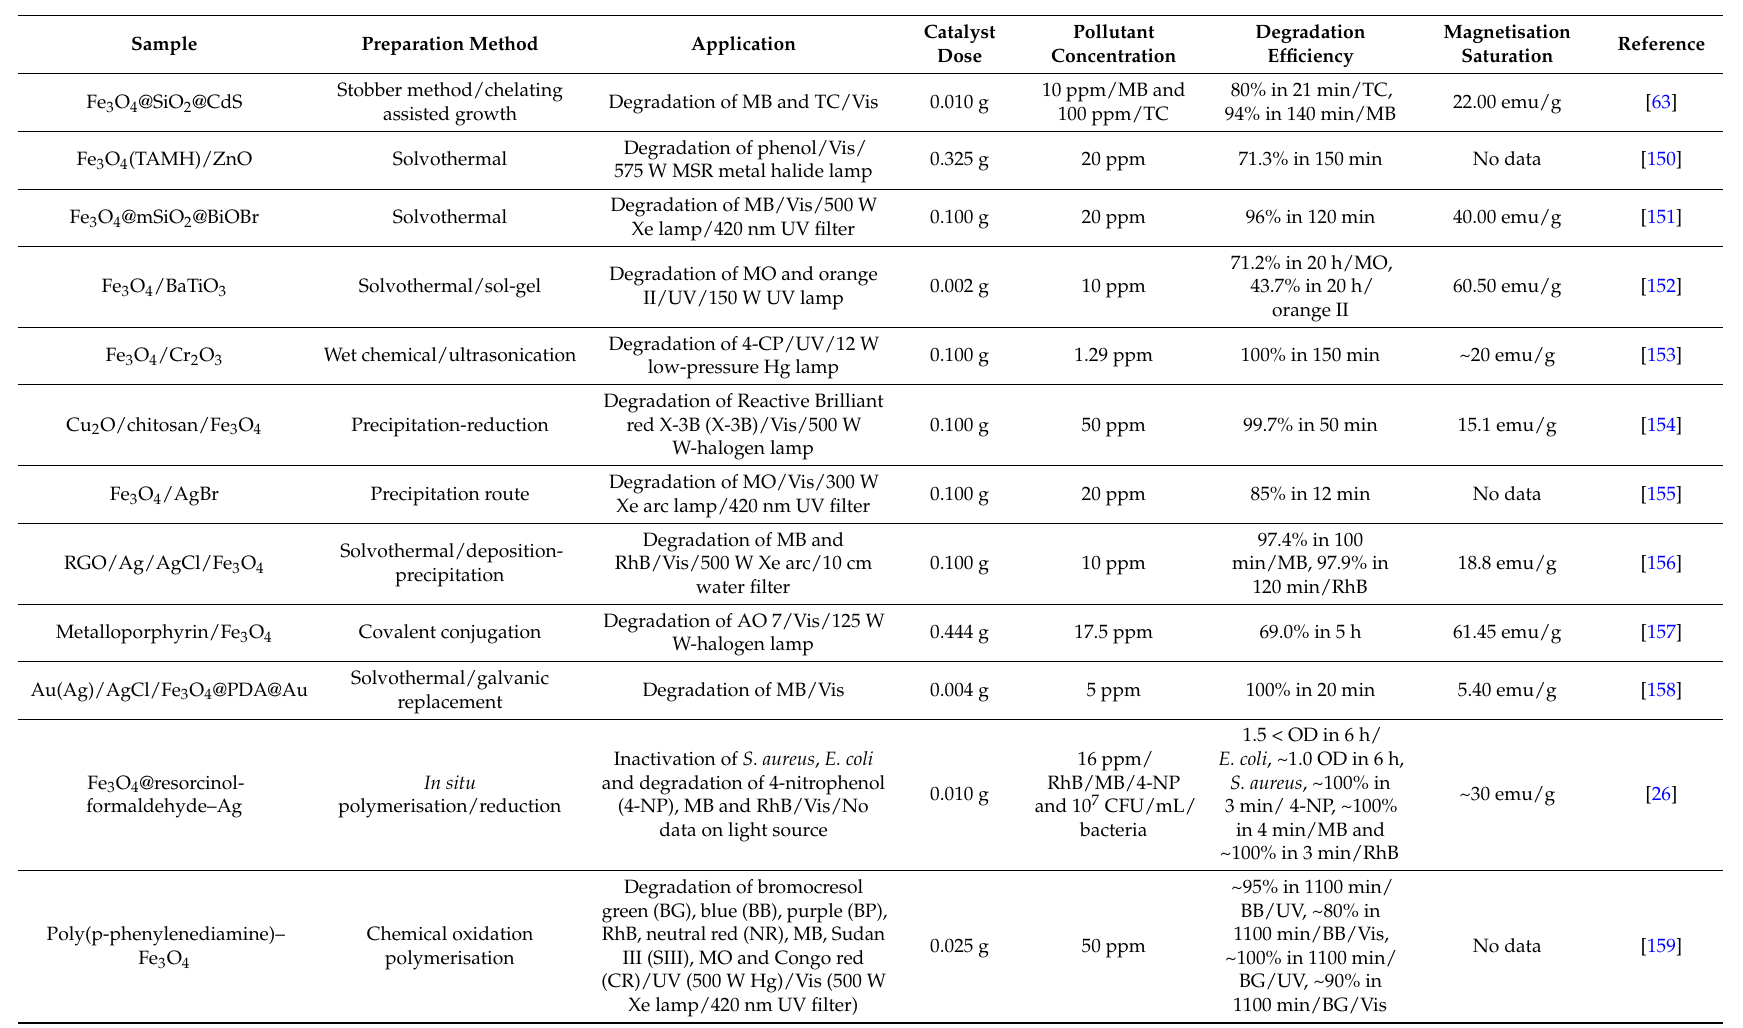
Table 2. Summary of the photocatalytic properties of various Fe 3 O 4 -based